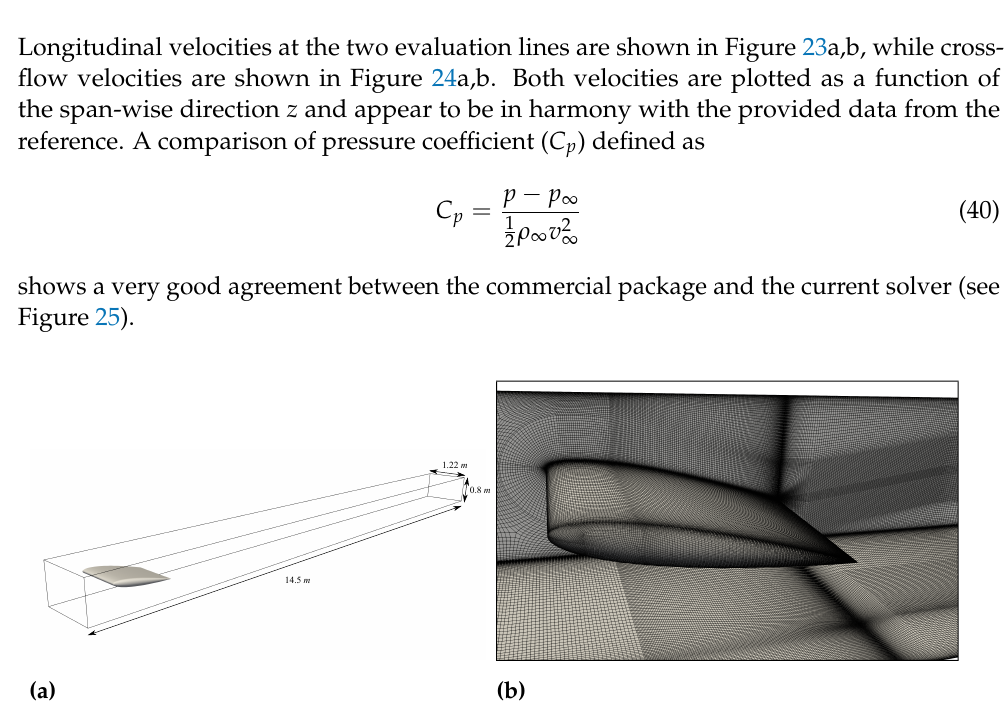
(b) Figure 19. Axial velocity distribution as produced by the (a) commercial package and (b) the current solver 7.3. 3D NACA0012 Wing Wind Tunnel Test 228 The third test case features an incompressible flow past a NACA0012 finite semi- span wing of chord length c = 1.22 m, fixed in a wind tunnel at 10 ◦ angle of attack. Figures 20a and 20b show the domain of the case and a sample mesh respectively. The